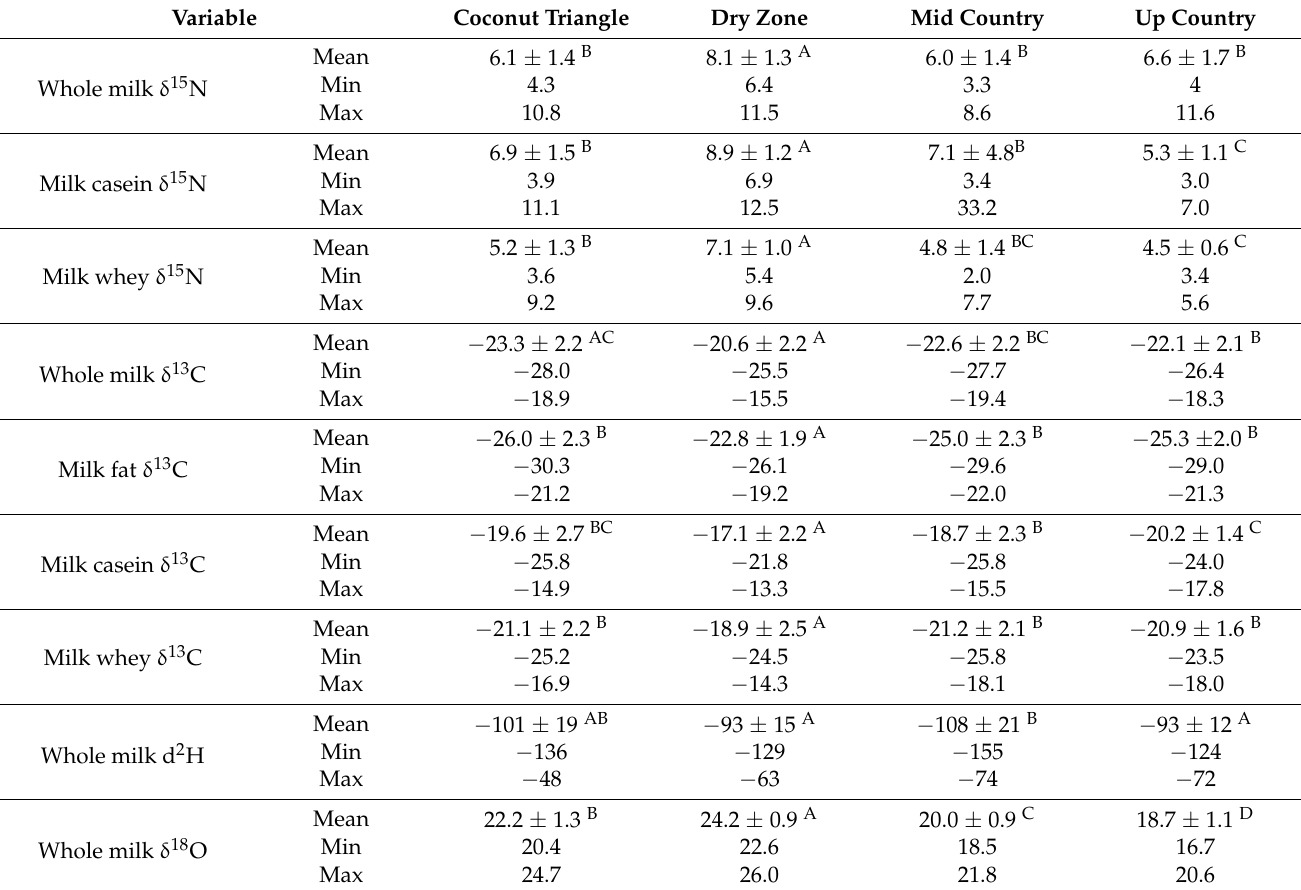
Table 2. Variation of mean, minimum, and maximum values of δ 13 C, δ 15 N, δ 18 O, and δ 2 H in milk and its components in each agroclimatic region. Data represent the mean ± standard deviation. Values in each row with different superscript letters differ for p <